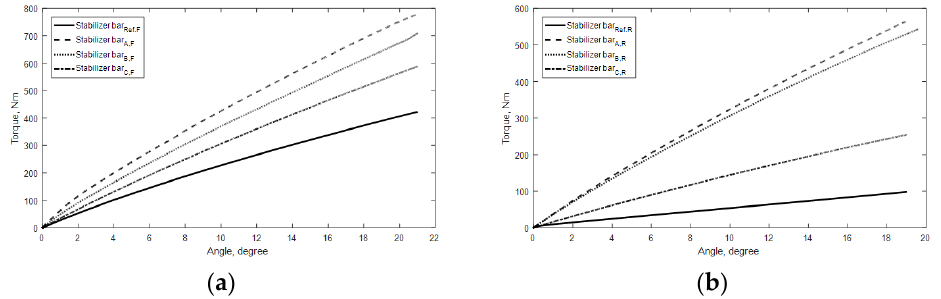
Figure 8. Stabilizer characteristics test results: ( a ) Front stabilizer characteristics; ( b ) Rear stabilizer characteristics.